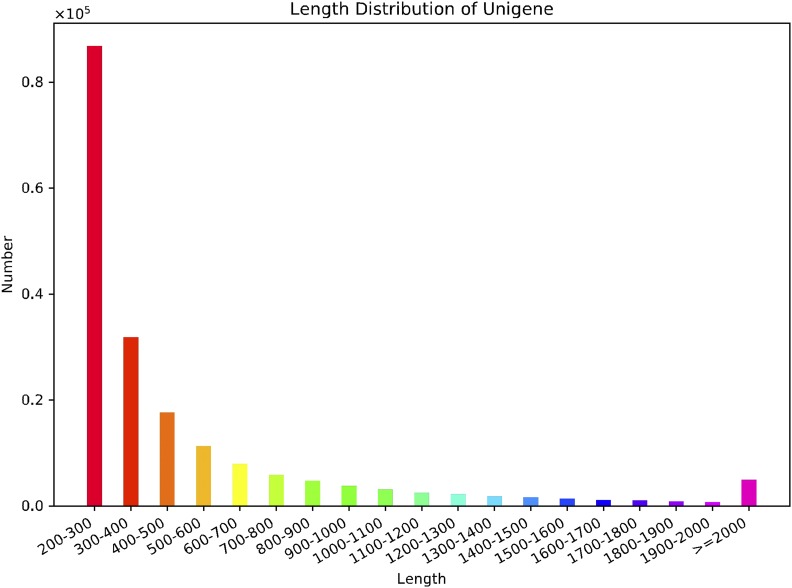
Length distribution of the obtained unigenes The x-axis represents the length, and the y-axis represents the number of unigenes.